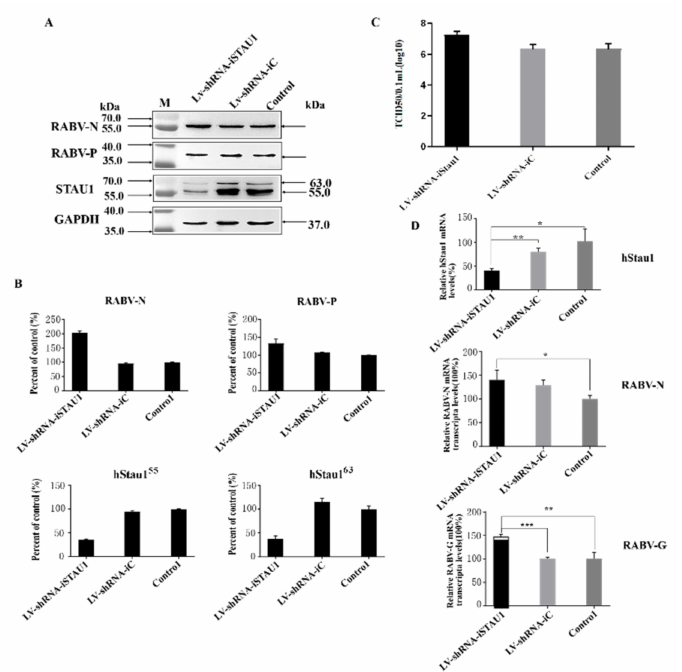
Figure 3. The effect of STAU1 downregulation on RABV replication. ( A ) Western blot to detect STAU1 expression in STAU1 knockdown cell lines and the effect of STAU1 downregulation on RABV-N, RABV-P expression, 48 h post-infection with RABV. ( B ) RABV-N, RABV-P and STAU1 expression was normalized by comparison with control as 100% in Figure 3A. ( C ) Detection of TCID 50 of RABV after cells down-regulated STAU1. ( D ) RT-qPCR detection of STAU1 genes, virus N and G transcript changes after down-regulated STAU1 and infection of RABV. *, p < 0.05; **, p < 0.01; ***, p < 0.001. Note: In the figure, two homologous proteins of STAU1 are represented by hStau1 55 and hStau1 63 respectively; hstau1 is short for human Staufen 1